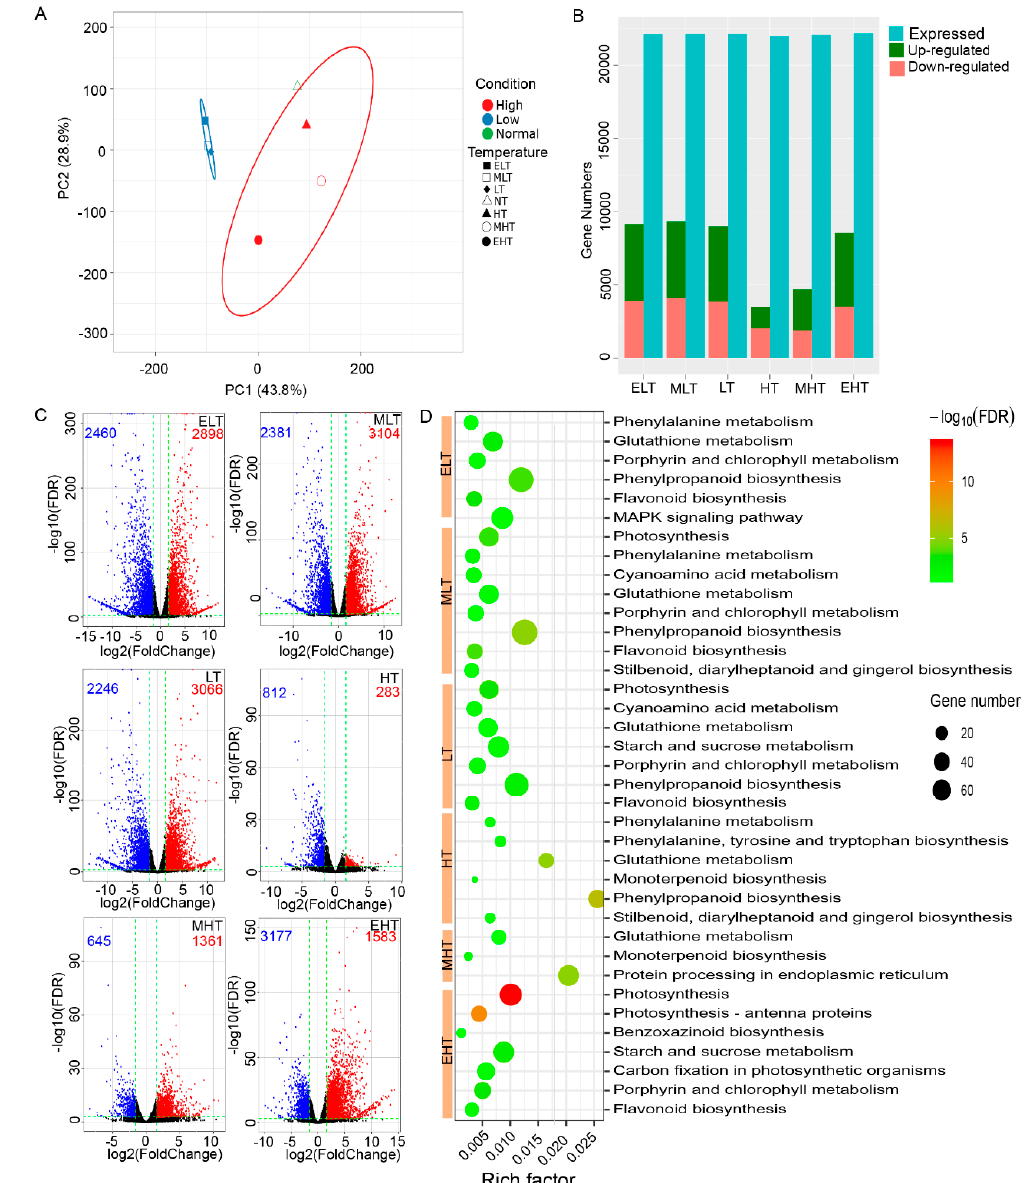
Figure 1. The expression characterizations of genes in response to temperature stress (TS) in maize seedling stage. ( A ) Principal component analysis (PCA) indicating the expression correlation among different temperature conditions. ( B ) The number of expressed genes and differentially expressed genes (DEGs) ( p < 0.05, |log2(Foldchange)| > 1) under cold and heat stress. ( C ) Volcano plot indicating the DEGs with stricter standards ( p < 0.001, |log2(Foldchange)| > 1.58). ( D ) KEGG enrichment analysis for the DEGs identified by strict standard. ELT, extreme low temperature, 4 ◦ C; MLT, medium low temperature, 10 ◦ C; LT, low temperature, 16 ◦ C; NT, normal temperature, 25 ◦ C; HT, high temperature, 37 ◦ C; MHT, medium high temperature, 42 ◦ C; and EHT, extreme high temperature, 48 ◦ C.